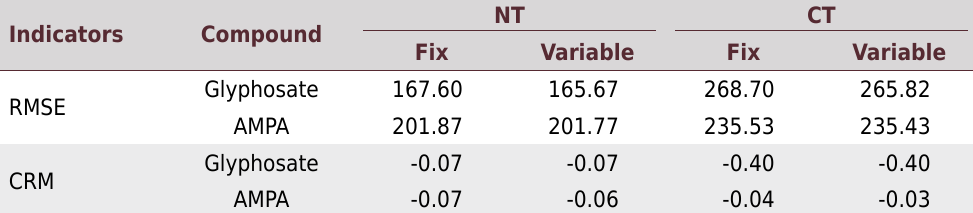
Table 2. Statistical indicators values for HYDRUS 1-D predictions of vertical distribution in the soil profile of glyphosate and AMPA, with constant (Fix) and time-variables (Variable) hydraulic parameters during the crop